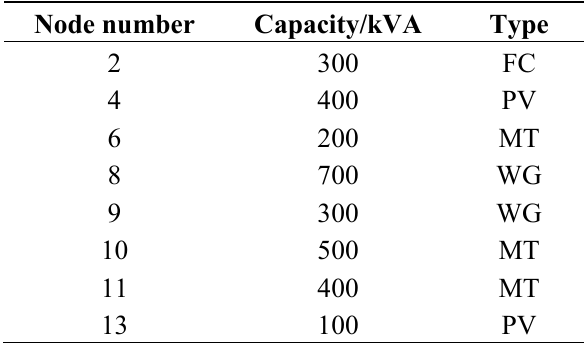
Table 3. The optimization scheme of DG.